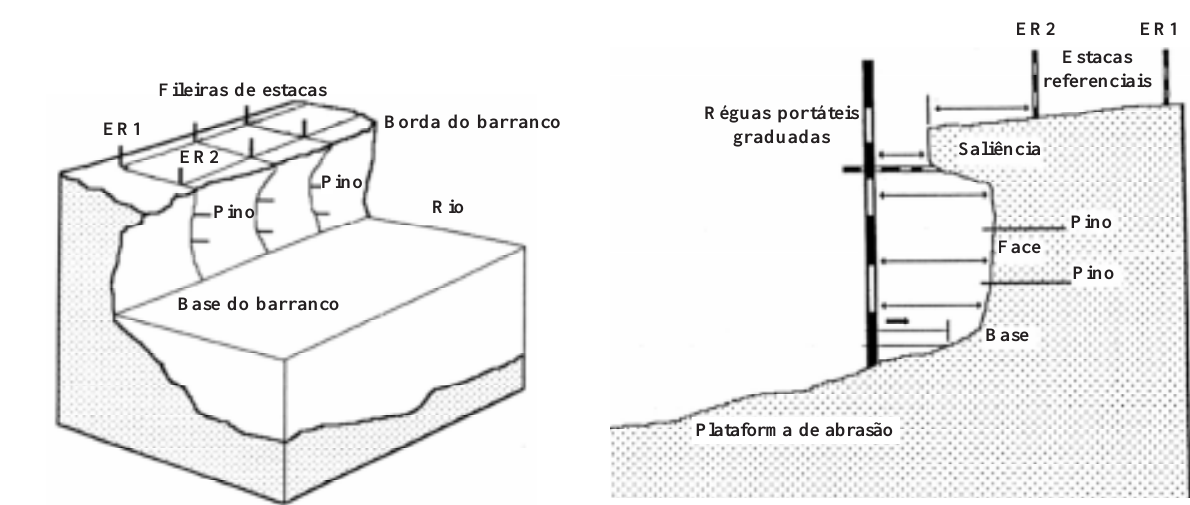
Figura 2. Localização das seções instrumentadas.